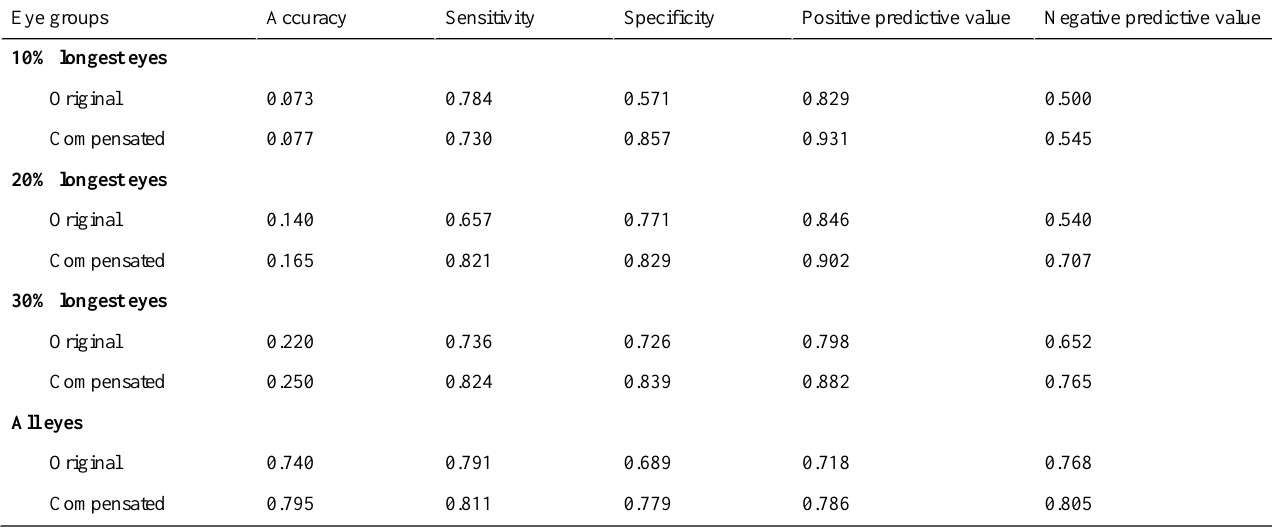
Table 2. Performance of the original retinal nerve fiber layer (RNFL) and the compensated RNFL to detect glaucoma in subgroups and all eyes of the validating